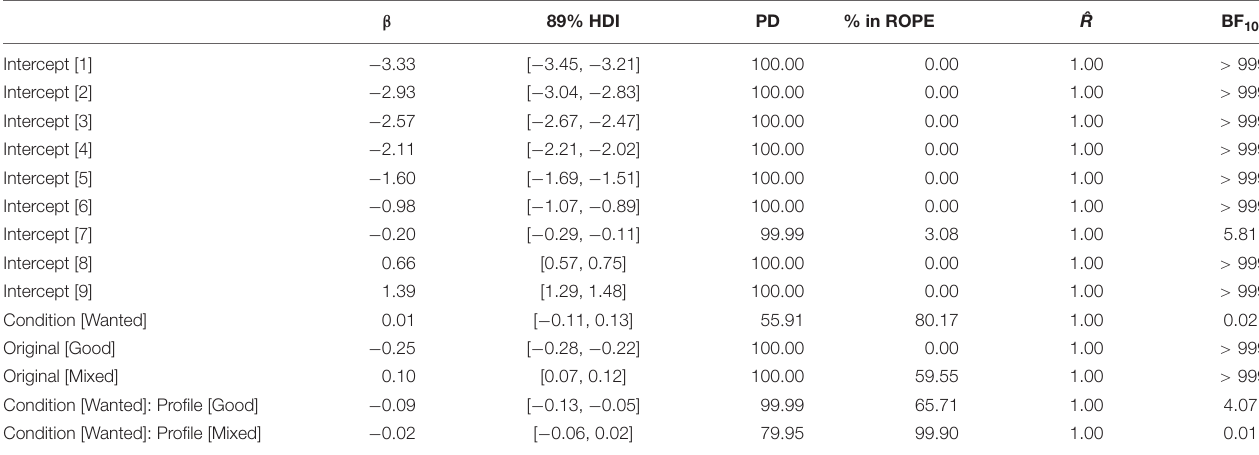
TABLE 12 | Summary of the model fitted to the judgment confidence data, considering the experimental conditions (Avoided or Wanted) and Profile type (Good, Mixed, and Bad).